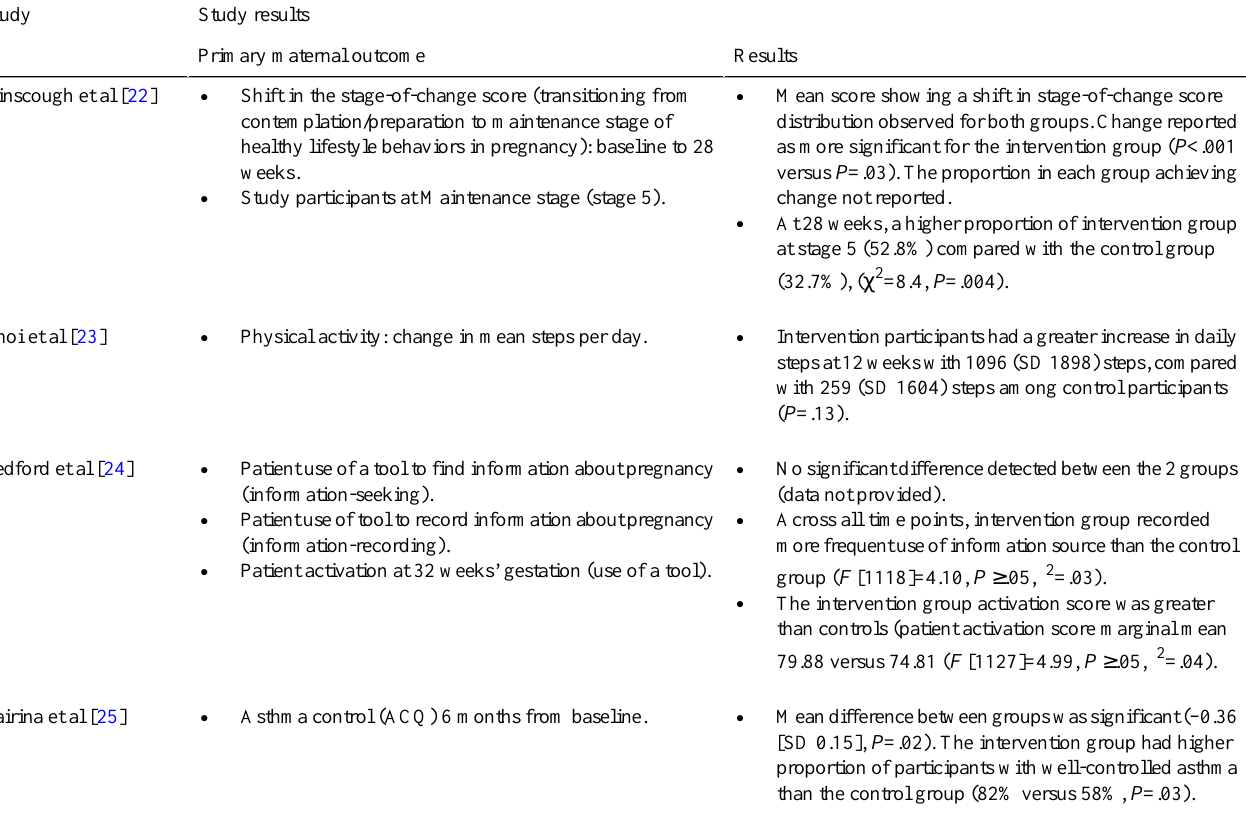
Table 5. Primary maternal outcomes: change in maternal behaviors by intervention goals. Study